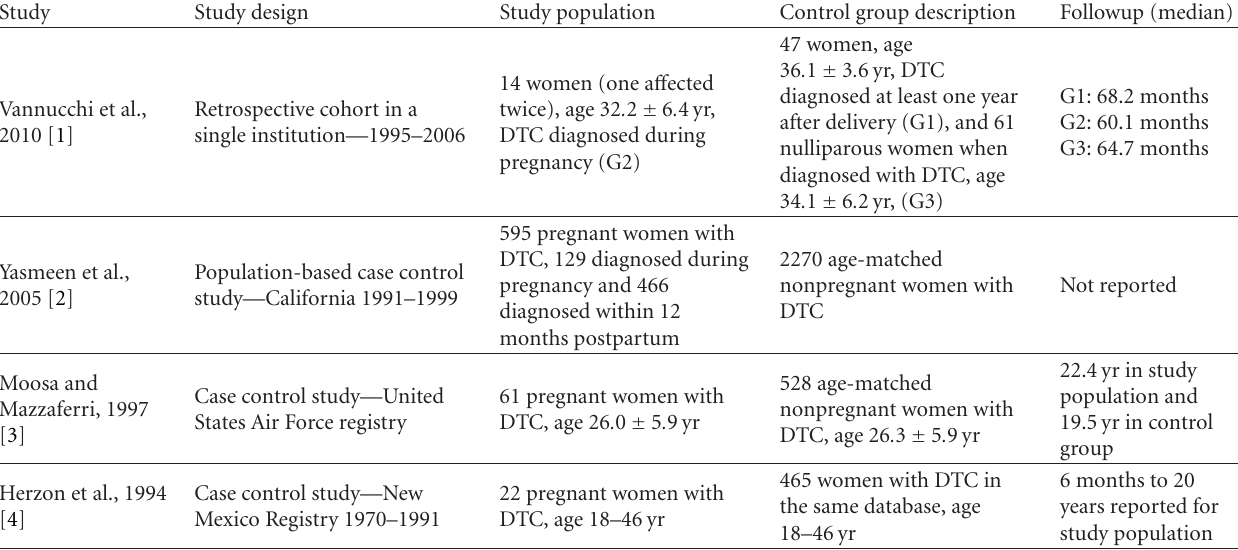
Table 1: Characteristics of the included